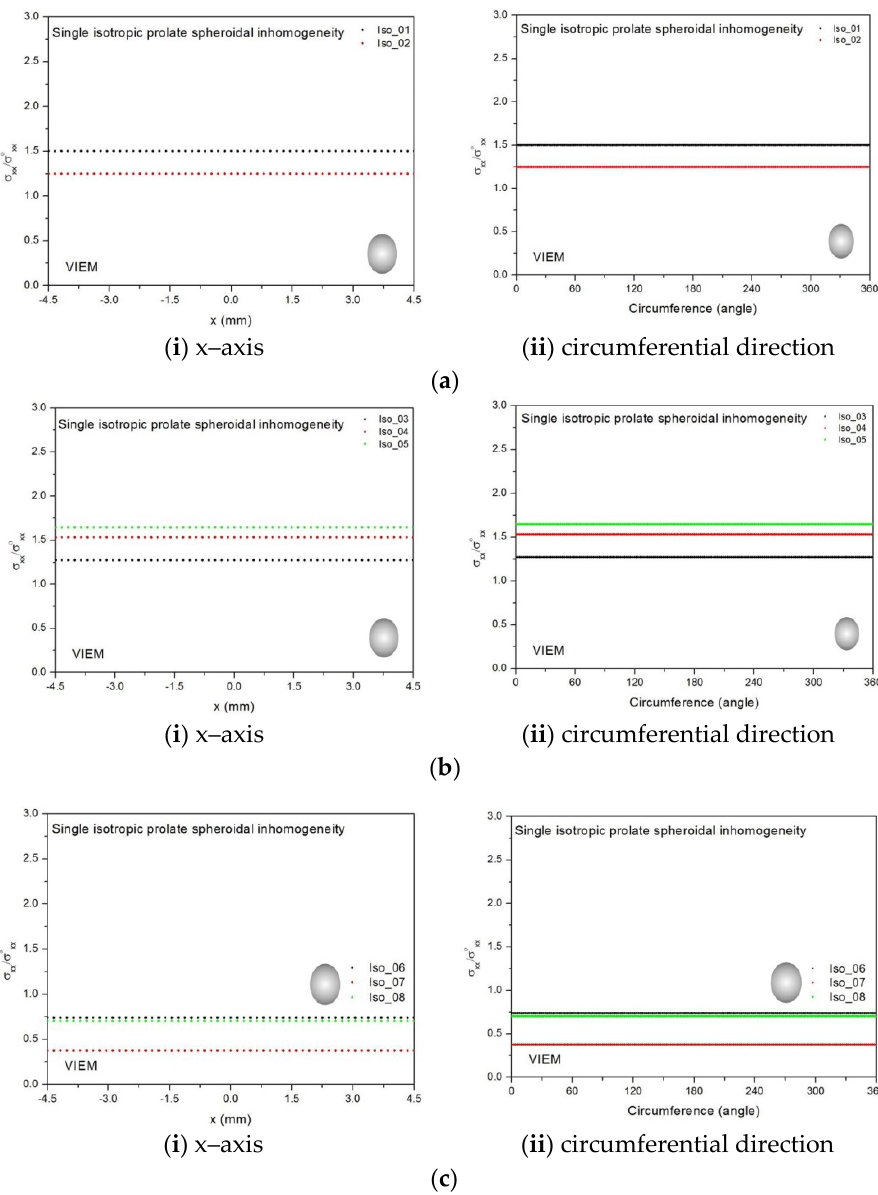
Figure 13. VIEM results for the normalized tensile stress component ( σ xx / σ oxx ) along ( i ) the x–axis inside and ( ii ) the circumferential direction of the isotropic prolate spheroidal inclusions with a/b = c/b = 0.75 (b = 6 mm) under uniform remote tensile loading. ( a ) Iso_01 and Iso_02. ( b ) Iso_03, Iso_04 and Iso_05. ( c ) Iso_06, Iso_07 and Iso_08. Table 10. Normalized tensile stress component ( σ xx / σ oxx ) within the isotropic prolate spheroidal in- clusion due to uniform remote tensile loading ( σ oxx ).